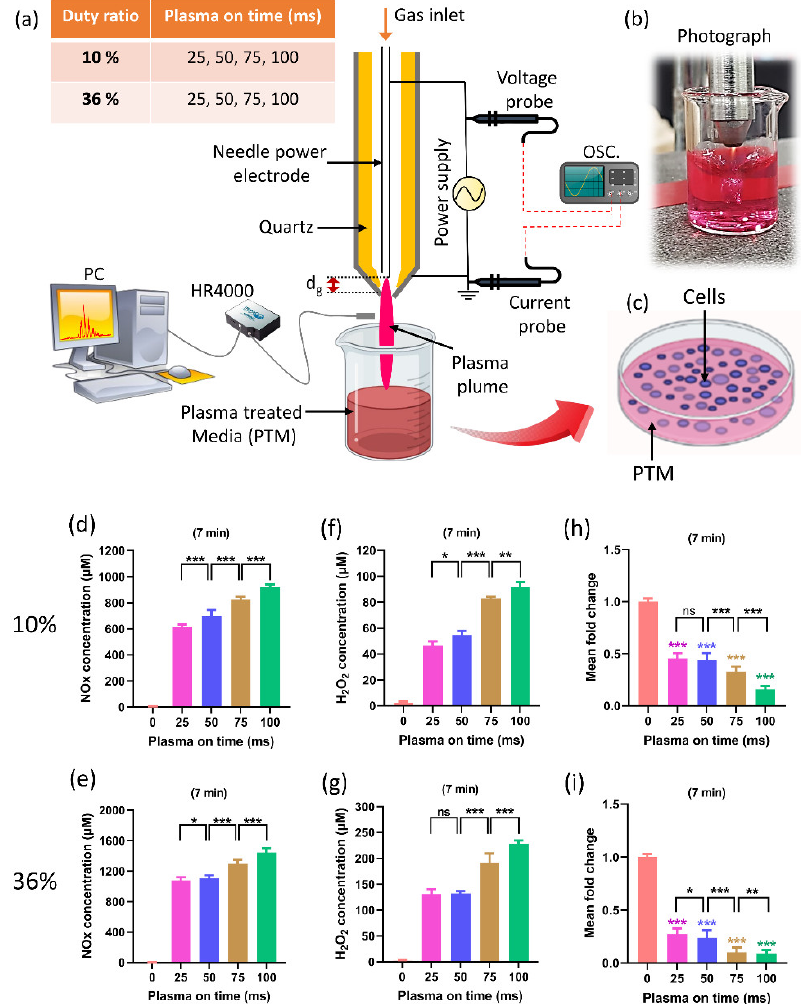
Figure 5. ( a ) The schematic of soft plasma jet and experimental setup. When preparing PTM, two fixed duty ratios of 10% and 36% were kept, as well as a fixed treatment time of 7 min; only the plasma on-time was changed (25, 50, 75, and 100 ms). ( b ) Photograph of soft jet during treatment, and ( c ) the application of PTM to the U87-MG cell line. ( d , e ) The NO x content in PTM by changing the plasma on-time when duty ratio (10% and 36%) and treatment time are fixed. ( f , g ) H 2 O 2 content corresponding to plasma on-time in 10% and 36% duty ratio. ( h , i ) The cell viability by changing the plasma on-time. The NO x and H 2 O 2 content significantly increased when only plasma on-time increased to 25, 50, 75, and 100 ms which shows further decline in the viability of brain cancer cells [67]. The significance of treatment groups indicated by * p < 0.05, ** p < 0.01, *** p < 0.001, ns—not significant.